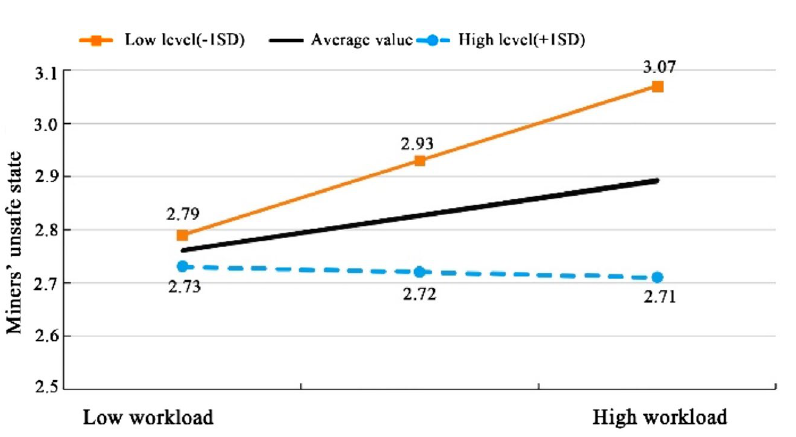
Figure 2. Simple slope diagram of the moderating effect of job